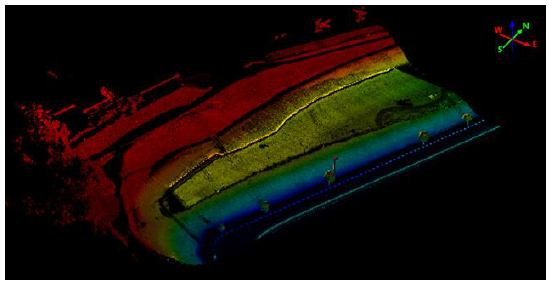
Figure 9. Mobile laser scanning data after cleaning process